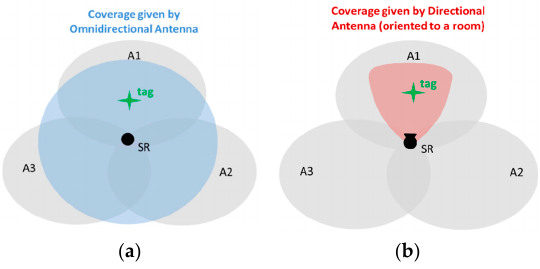
Figure 6. Scenario defined with three areas: A1, A2 and A3. Coverage comparison between ( a ) the omnidirectional antenna and ( b ) the directional antenna oriented toward A1.